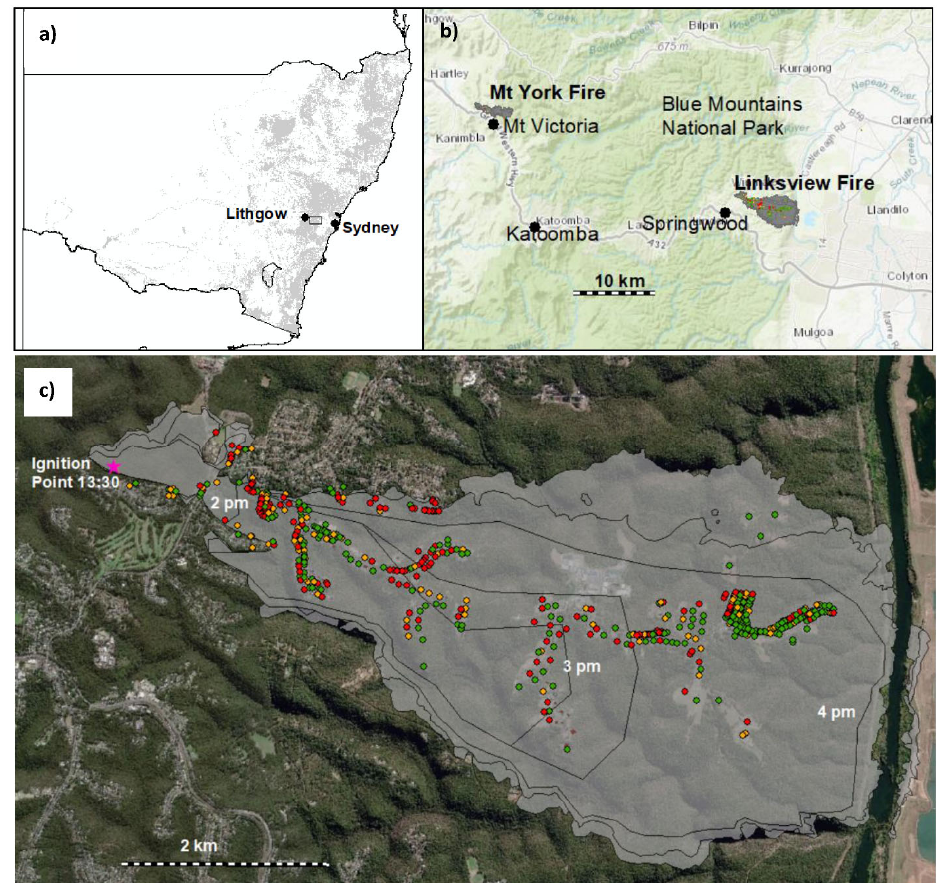
Figure 2. ( a ) The location of the study area (black outline) in NSW; ( b ) the study area showing the location of the two fires in the Blue Mountains region; and ( c ) the Linksview Fire showing the impact on individual houses. The background is an ESRI base map and the dark grey is the area burnt on 17 October 2013. Fire progressions are black lines with times in white text.